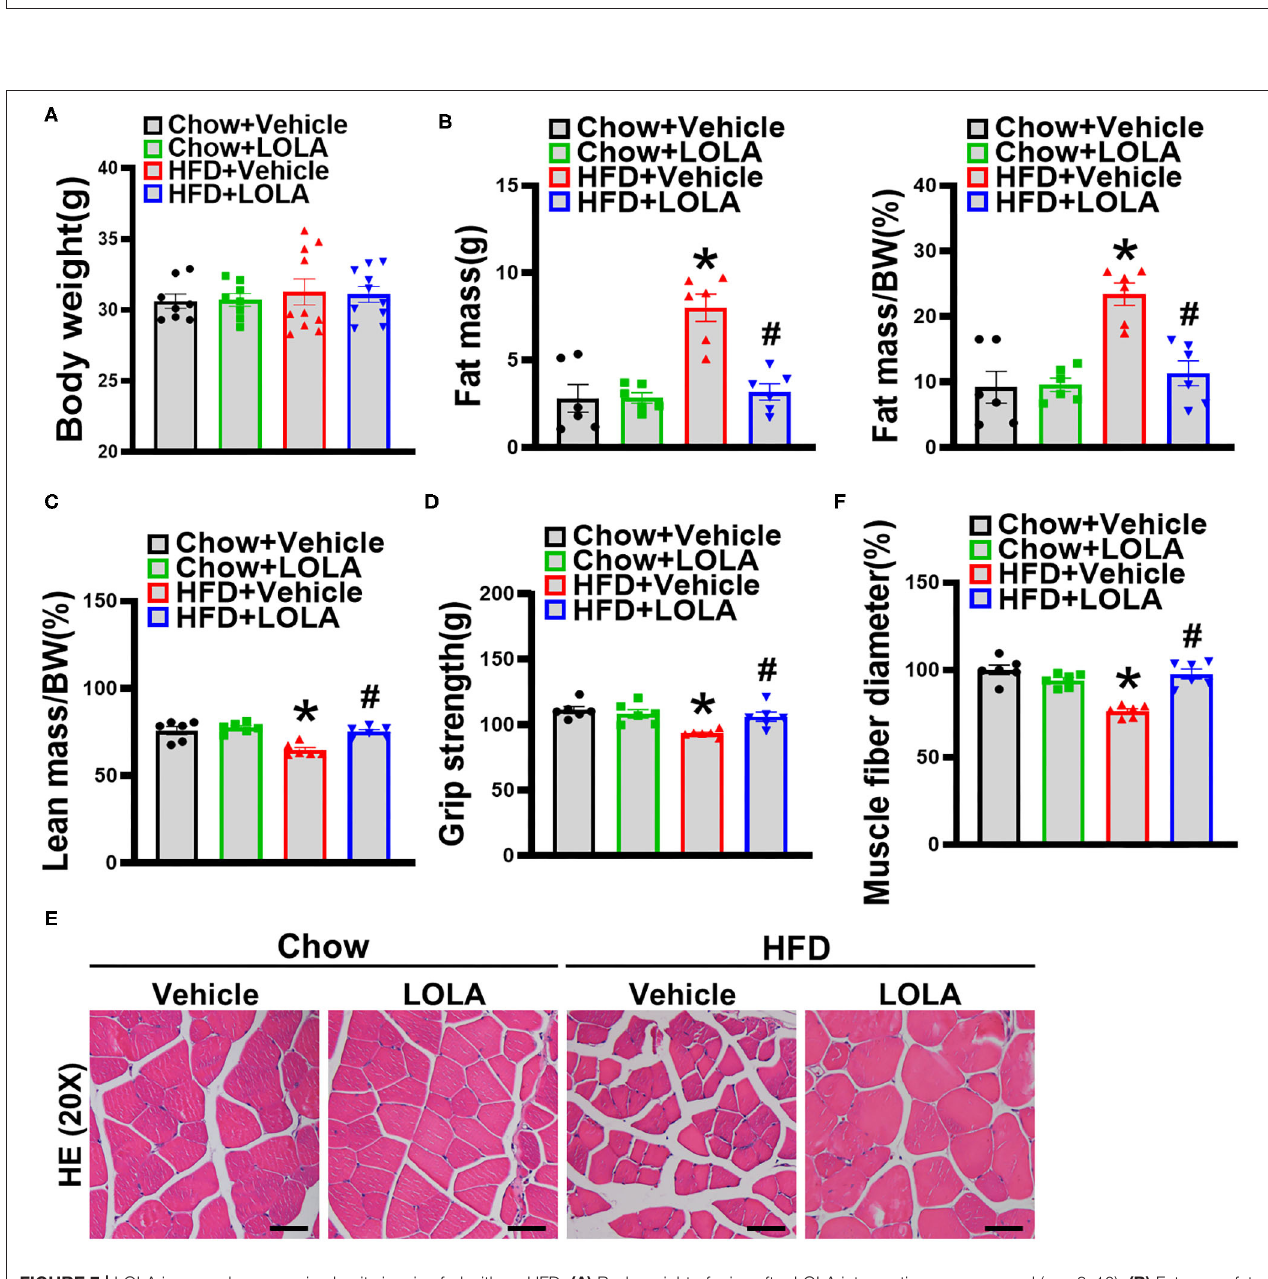
FIGURE 7 | LOLA improved sarcopenic obesity in mice fed with an HFD. (A) Body weight of mice after LOLA intervention are measured ( n = 8–10). (B) Fat mass, fat mass/bodyweight (BW), (C) lean mass/BW are detected by NMR ( n = 6). (D) Forelimb grip strength is tested ( n = 6). (E) Representative hematoxylin and eosin staining pictures of quadriceps in mice ( n = 6) are shown (scale bar, 50 µ m). (F) Mean diameters of muscle fibers are quantified ( n = 6). The data are presented as the mean ± SEM, unpaired two-tailed Student’s t -test. * P < 0.05, vs. mice fed with chow diet; # P < 0.05, vs. mice fed with HFD.